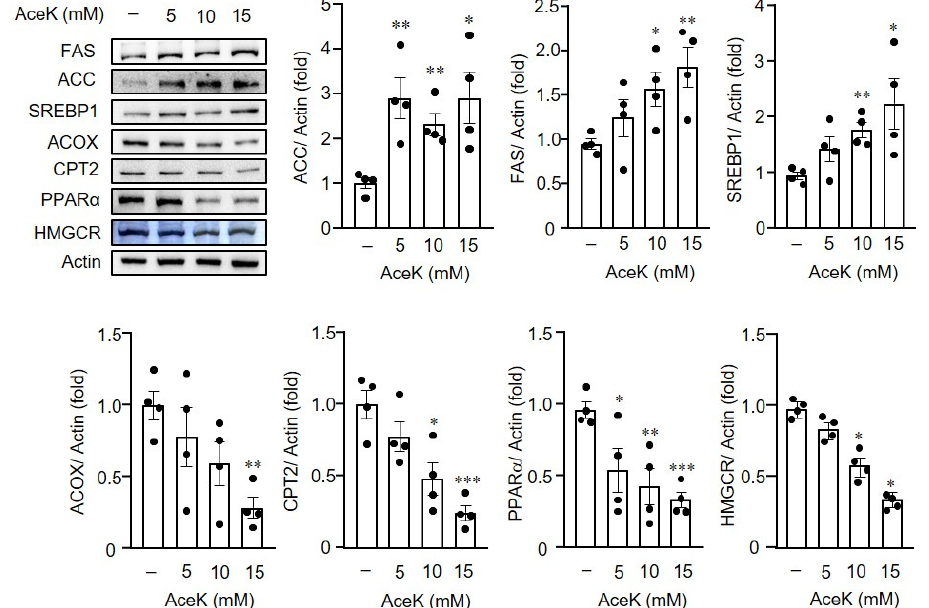
Figure 6. Effects of AceK on lipid metabolism-related protein expressions in HepG2 cells. HepG2 were treated with indicated doses of AceK for 24 h. The protein lysates were prepared for the quantification of acetyl-coA carboxylase (ACC), fatty acid synthase (FAS), sterol regulatory element binding protein-1 (SREBP1), peroxisomal acyl-coenzyme A oxidase (ACOX), carnitine palmitoyltransferase-2 (CPT2), peroxisome proliferator-activated receptor α (PPAR α ) and 3-hydroxy-3-methyl-glutaryl-coenzyme A reductase (HMGCR) protein expressions by Western blots ( n = 4). * p < 0.05, ** p < 0.01, *** p < 0.001.